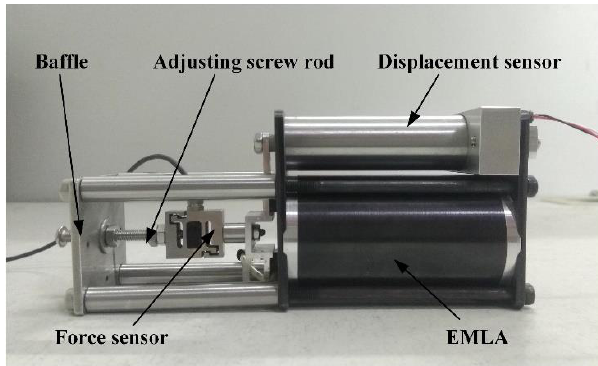
Figure 13. Experimental bench for the electromagnetic force characteristic.